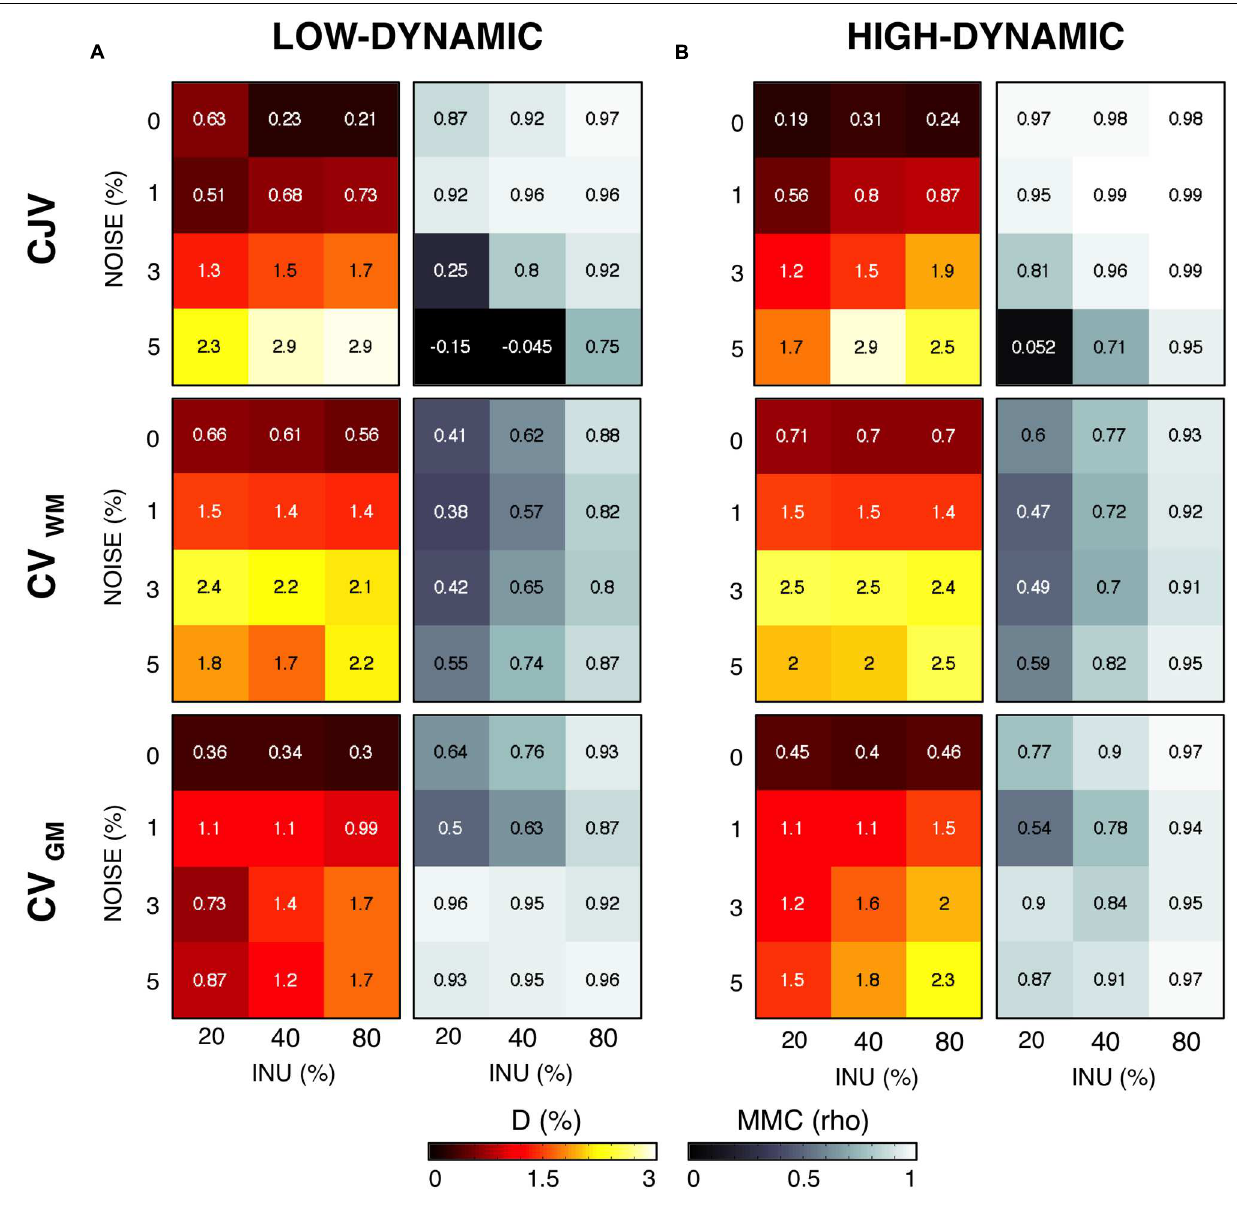
FIGURE 4 | Sensitivity of different metrics to inhomogeneity magnitude and noise. For each INU field magnitudes and noise level, we calculated the voxel-wise distance D between the simulated and the estimated INU fields, as well as the matrix-to-matrix correlation (MMC). We report in this figure the results for the parameter configuration identified by each metric. CJV, CV WM , and CV GM were compared for the low-dynamic (A) and high-dynamic (B) INU